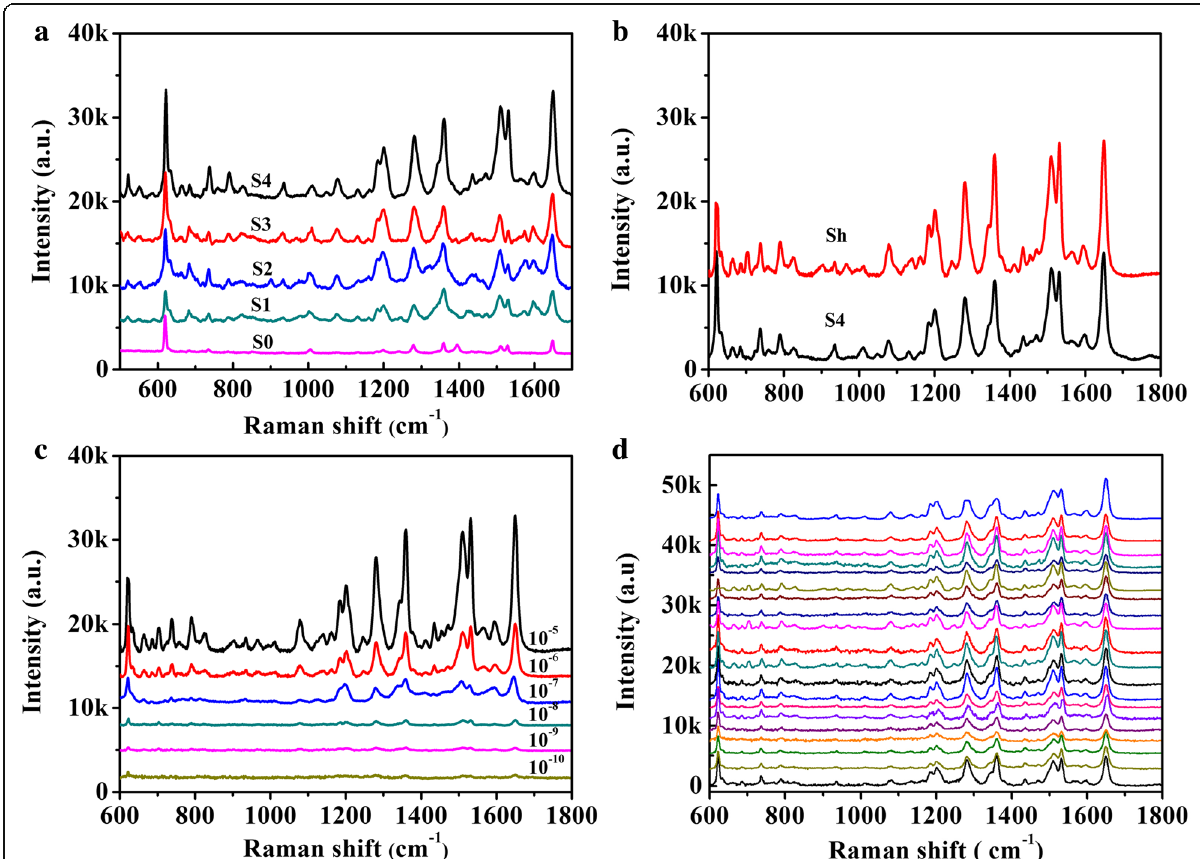
Fig. 8 a SERS spectra of 10 − 5 M RB on different AgNWs@AgNPs substrates, S0, S1, S2, S3, S4. b SERS spectra of RB with two different substrates RB (10 − 5 M) (Sh: superhydrophobic counterpart of S4). c SERS spectra of RB at different concentration on flexible and superhydrophobic substrate. d Reproducibility of the SERS signals at twenty random sites (10 − 6